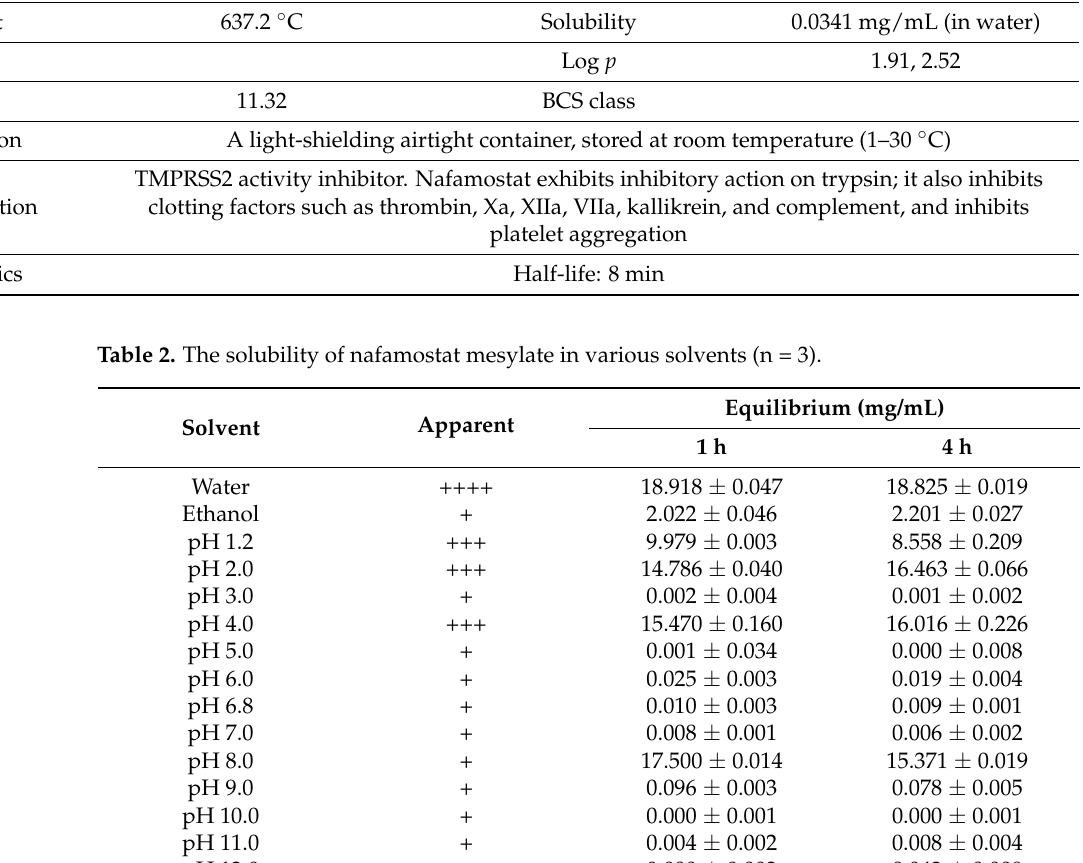
Table 2. The solubility of nafamostat mesylate in various solvents (n = 3).